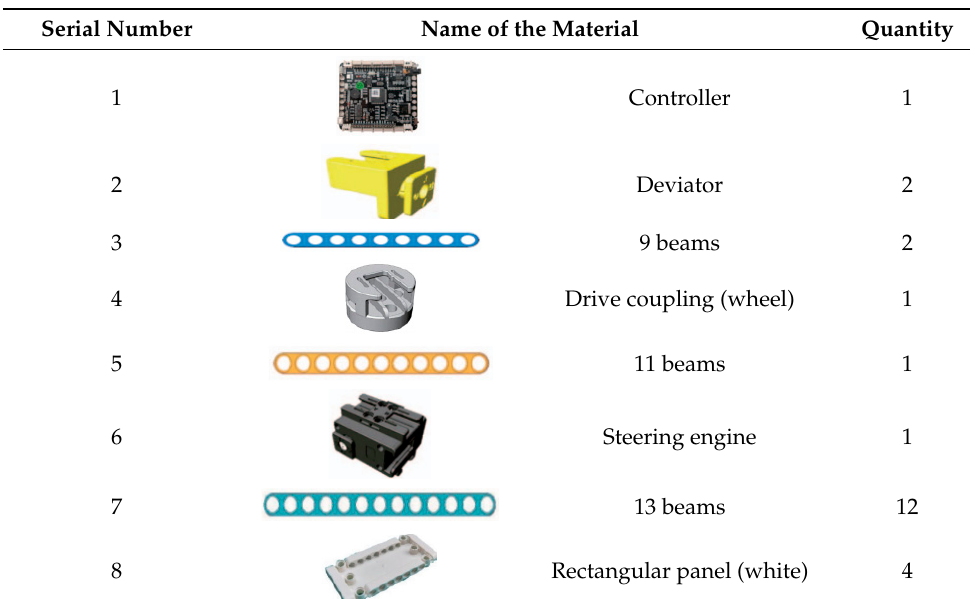
Figure 2. Noise detector design models. Table 1. Material bar of noise detector design.